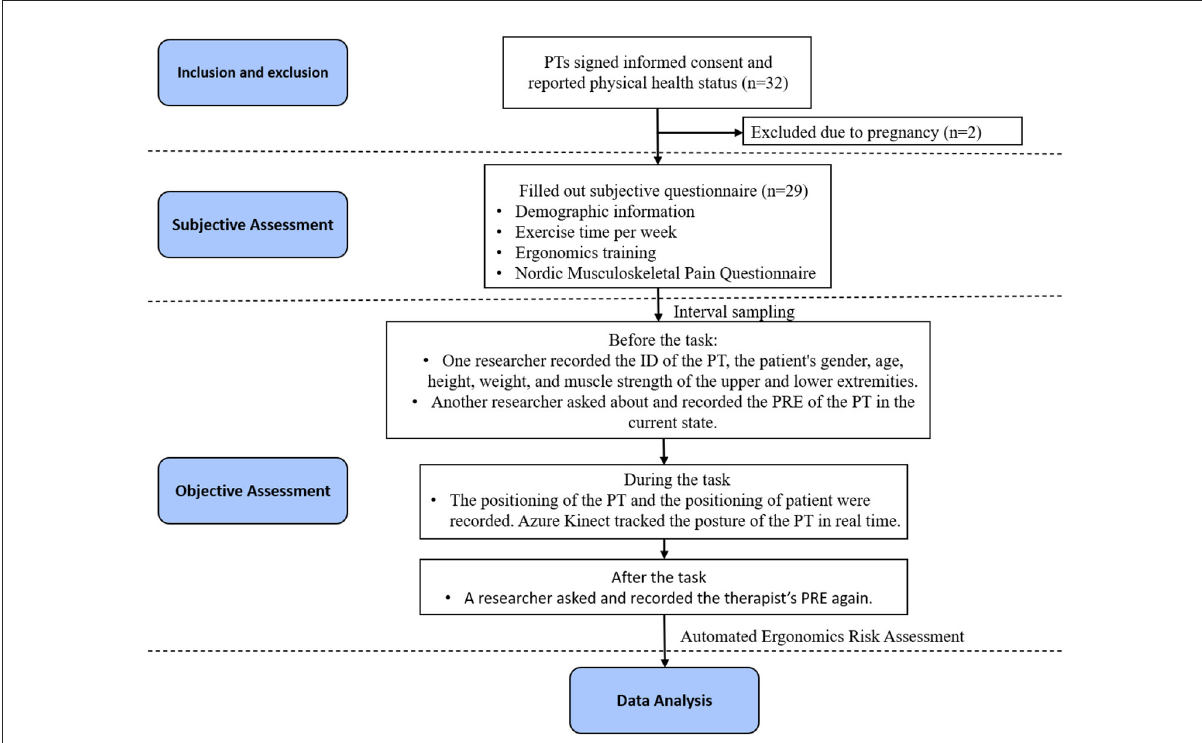
FIGURE2 Flowchart: after conducting the inclusion and exclusion of operational cases, 224 cases were included in analysis. Objective assessment was carried out in these cases to collect data from both physiotherapists and patients, followed by a subjective assessment including the demographic information and the body-parts and duration of pain of